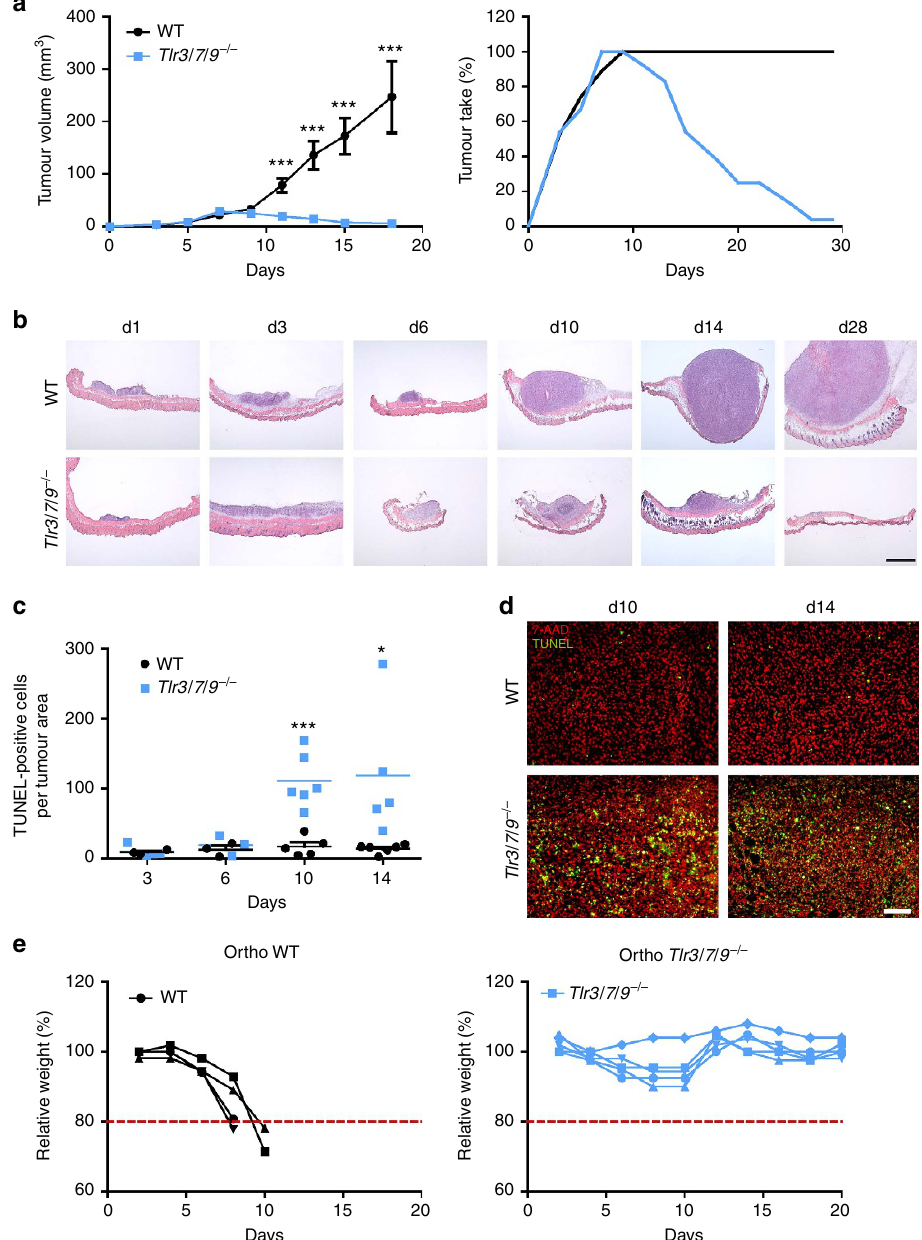
Figure 1 | Tlr3/7/9 (cid:2) / (cid:2) mice reject MOPC tumours within 3 weeks through induction of cell death. ( a ) MOPC tumour cells (0.5 (cid:3) 10 6 ) were s.c. injected into the right flank of 8- to 16-week-old C57BL/6 WT ( n ¼ 19) and Tlr3/7/9 (cid:2) / (cid:2) mice ( n ¼ 24). Mean of tumour growth ± s.e.m. and tumour take (percentage of mice with a palpable tumour) are shown. Three stars (***) indicate statistical difference P r 0.0005 ( t -test). ( b ) Frozen sections of s.c. tumours, dissected at different time points after tumour cell injection (day 1 to day 28), were stained by haematoxylin–eosin staining. One representative example for each time point is shown. Scale bar, 1,000 m m. ( c ) Quantification of dead cells in MOPC tumours was determined by calculating the area of TUNEL-positive cells in relation to the entire tumour area at day 3, day 6, day 10 and day 14 after tumour cell injection ( n ¼ 3–6). Single values and mean (horizontal line) are shown. Results were considered significant at * P r 0.05 and *** P r 0.0005 ( t -test). ( d ) Representative examples of the TUNEL staining at day 10 and day 14 of tumours of WTand Tlr3/7/9 (cid:2) / (cid:2) mice. Green: TUNEL, red: 7-AAD nuclear staining. Scale bar, 100 m m. ( e ) Tumour growth of 0.5 (cid:3) 10 6 MOPC cells after orthotopic (ortho) injection into the floor of the mouth in 8- to 12-week-old C57BL/6 WT ( n ¼ 4) and in Tlr3/7/9 (cid:2) / (cid:2) mice ( n ¼ 5). Relative weight of the mice is shown. Mice were killed if they lost 20 % of their initial weight, indicated by the dotted red